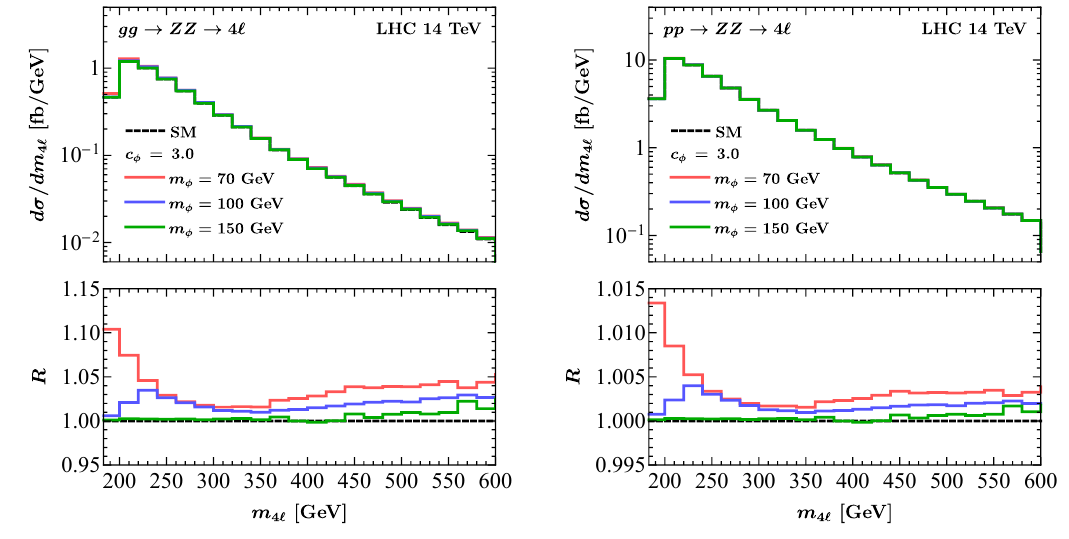
Figure 2 . m 4 ‘ spectra in the SM (dashed black) as well as for three Higgs portal model sce- narios (1.1) assuming c φ = 3 and m φ = 70 GeV (solid red), m φ = 100 GeV (solid blue) and m φ = 150 GeV (solid green). The left (right) plot shows results for gg → ZZ → 4 ‘ ( pp → ZZ → 4 ‘ ) production. All distributions correspond to QCD-improved predictions and LHC collisions at a √ centre-of-mass energy of s = 14 TeV . The lower panels depict the ratios between the BSM distri- butions and the corresponding SM